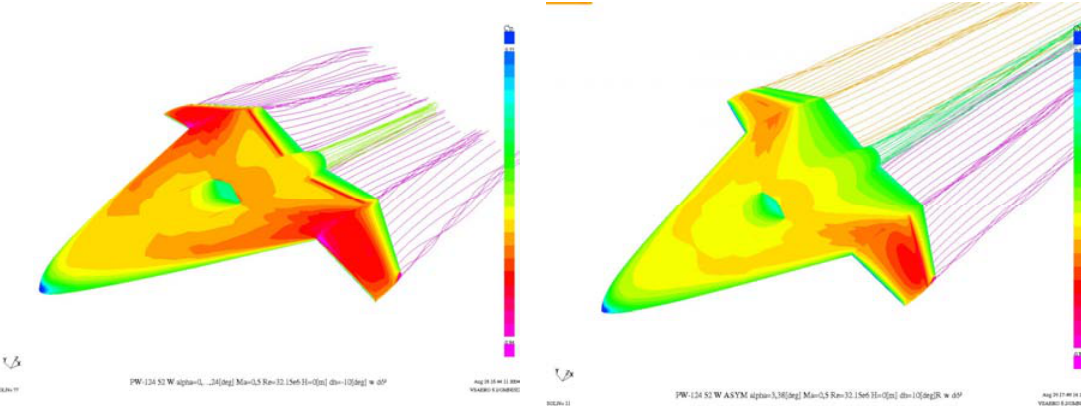
Fig 17. Cp distribution for PW -124 HALE aircraft at